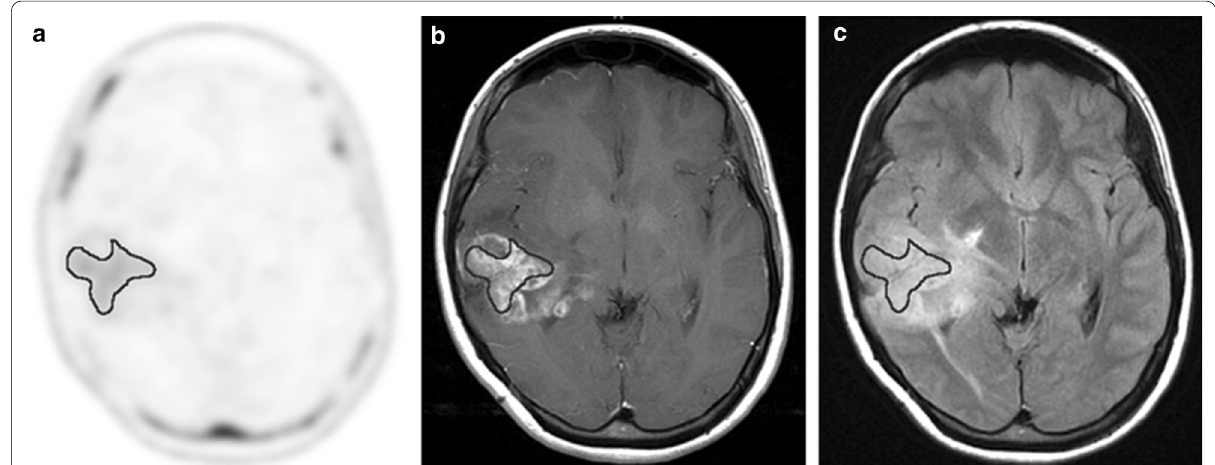
Fig. 2 Radiologic images of a 29-year-old female with newly diagnosed glioblastoma. Transverse 4DST PET image a shows inhomogeneous uptake in the right temporal lobe (SUVmax 1.87, T/N ratio 5.84, PTV 25.46 cm 3 ). Transverse T1-weighted MRI with Gd enhancement b shows = = = inhomogeneously enhanced lesion in tumor (GdV 35.84 cm 3 ). Region of interest shows proliferation area drawn on 4DST PET image from a. The = proliferation area on 4DST PET image and Gd enhancement area on MRI differed slightly. The hyperintense area identified on transverse FLAIR MRI c is larger than the proliferation area on 4DST PET image (FLAIRV 196.16 cm 3 =